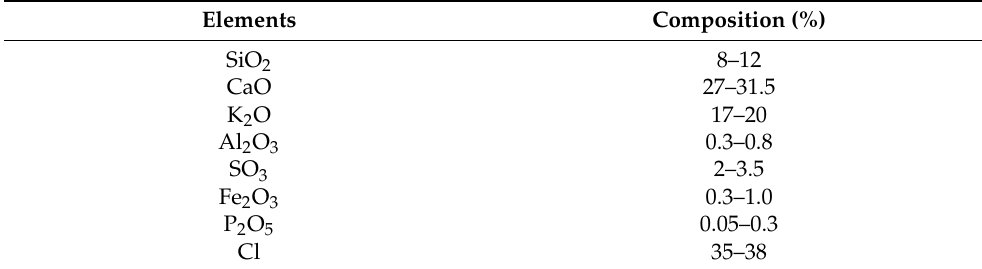
Figure 8. General method for the synthesis of silica from coconut shell waste. Table 3. Elemental composition of coconut husk ash